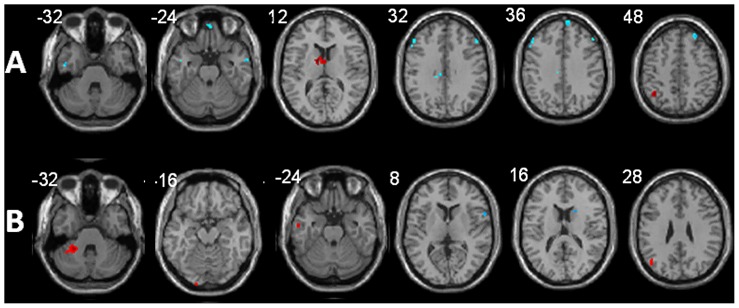
Modulation of functional connectivity (FC) in relation to the anterior cingulate cortex (ACC) by PASAT performance in healthy controls (A) and MS patients (B).Areas demonstrating increased FC with better performance are shown in red, areas demonstrating increased FC with worse performance are shown in blue (selected axial slices in neurological convention). For further explanations please see text.